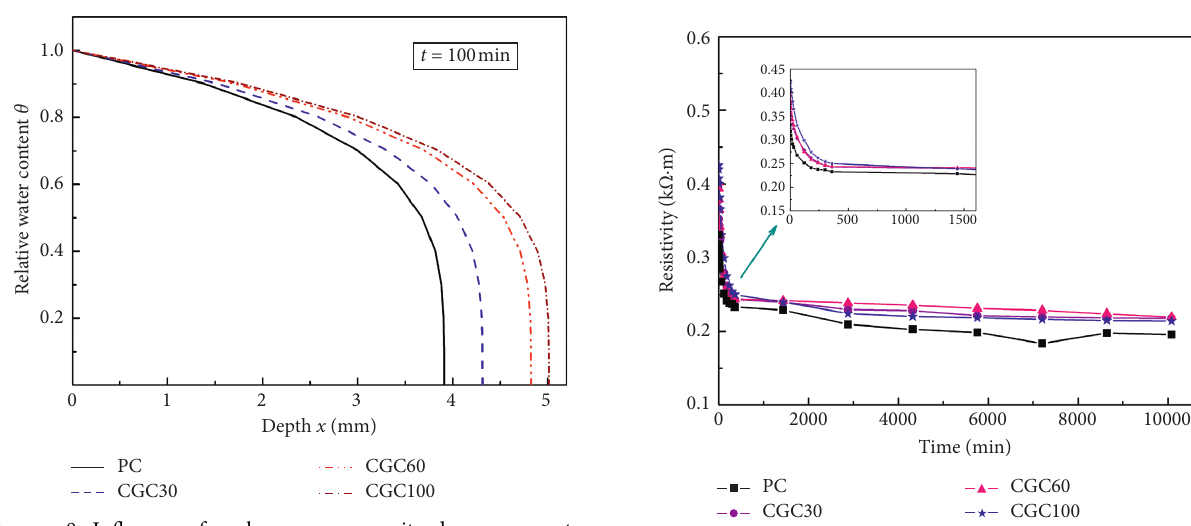
Figure 9: Resistivity of different